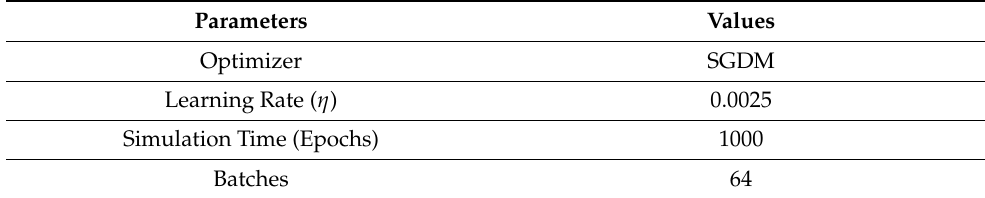
Table 8. P-MLP model training